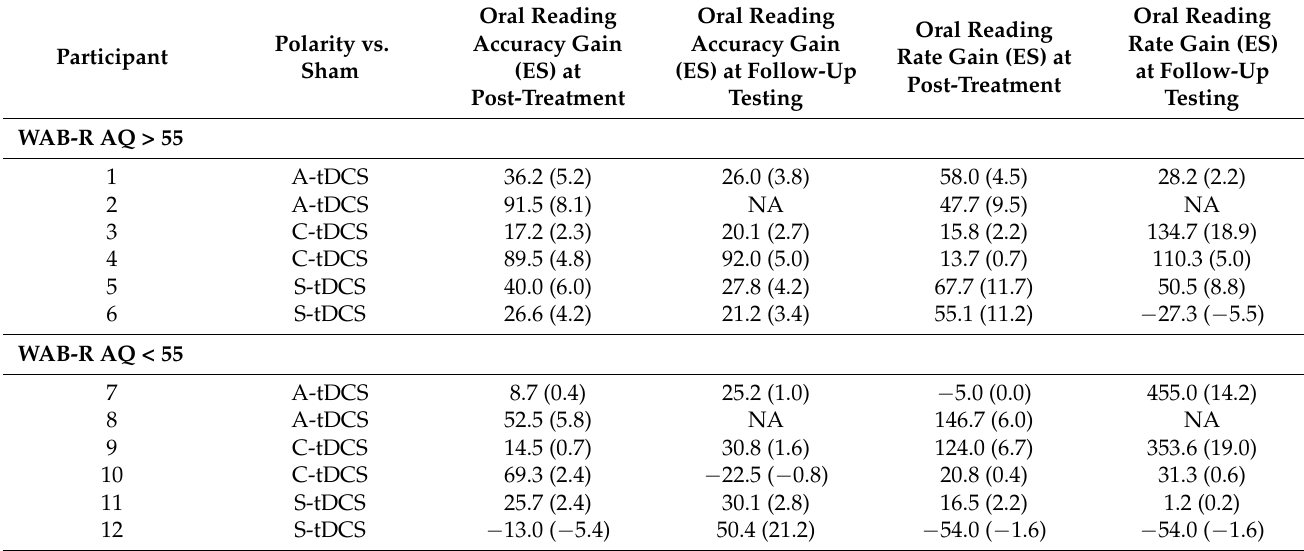
Table 6. Individual scores and percent gain (effect size) in oral reading accuracy and rate (wpm) per the Naming and Oral Reading for Language in Aphasia 6-point scale